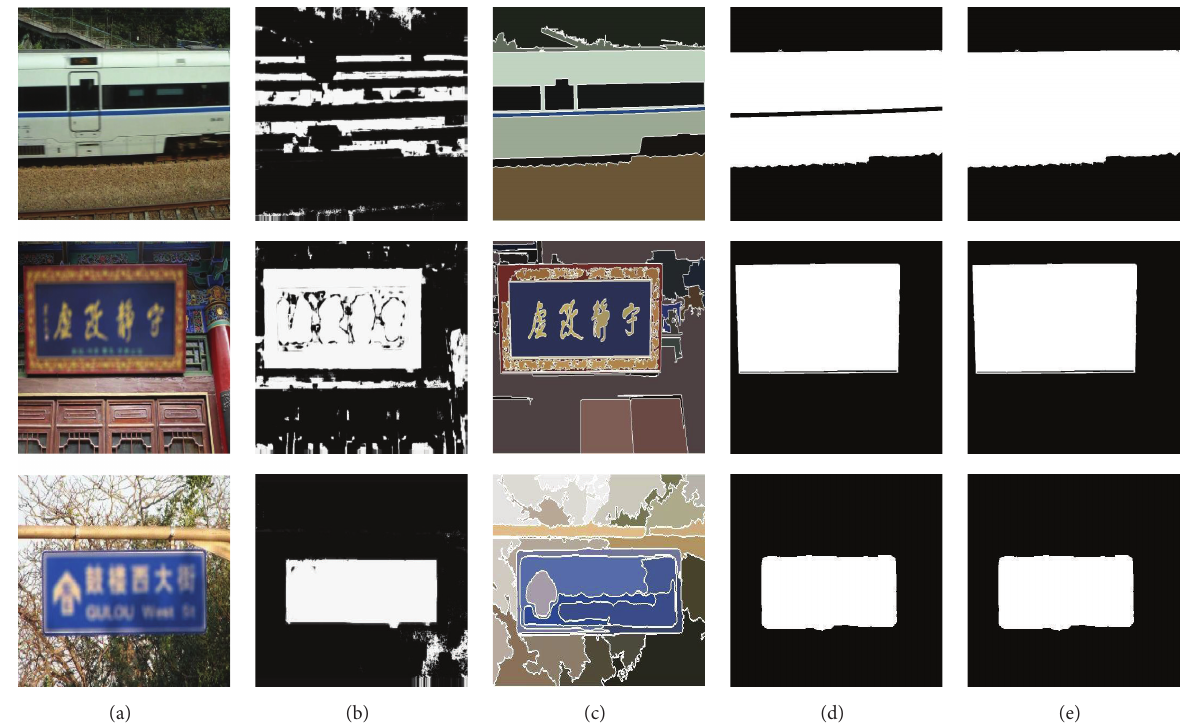
Figure 3: Results of blur detection. (a) Partial blurred images. The train in the centre of the image which lies in the first row is blurred artificially using 8-pixel 0-degree motion blur kernel; the other regions are clear regions. The plaque in the centre of the image which lies in the second row is blurred artificially using 8-pixel defocus blur kernel; the other regions are clear regions. The guideboard in the centre of the image which lies in the third row is blurred artificially using a blend blur kernel whose motion blur scale and defocus blur scale are 5 pixels and motion direction is 0 degrees; the other regions are clear regions. (b) Shi’s results. (c) Segmentation results. (d) Detection results based on image segmentation. (e) Final results after refining based on neighbour